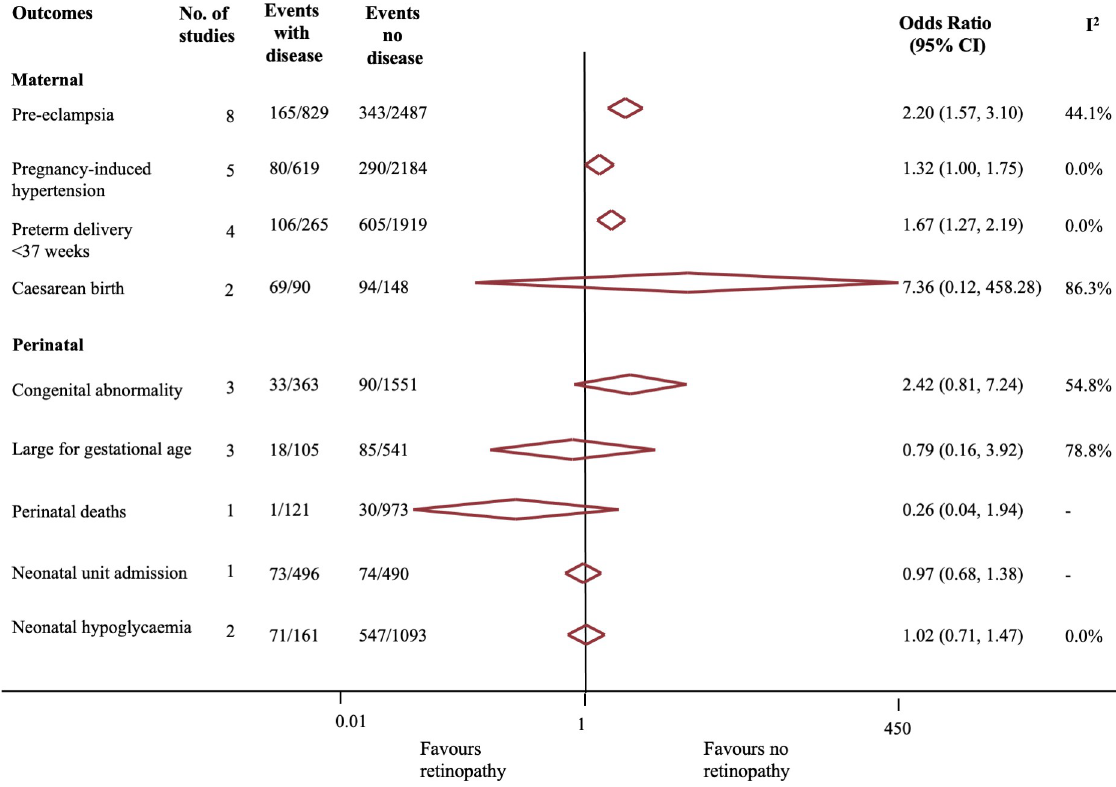
Fig 4. Association between diabetic retinopathy and adverse maternal and perinatal outcomes.